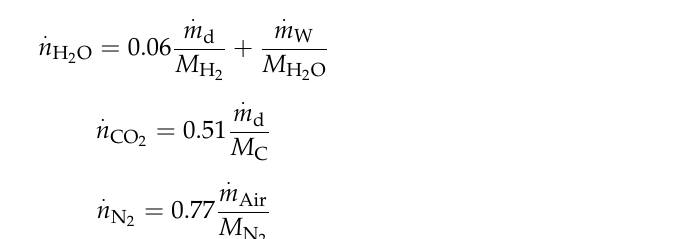
Figure 6. Measured and predicted outputs: moisture evaporation rate, fuel burning rate and flue gas content. The dynamics of the model states, including the temperature of char and gas, as well as the amount of char, fuel and water on the grate, are presented in Figure 7. The predicted gas and burning char (solid) temperatures are in a good agreement with the values previously measured by Cooper and Hallett [28]. The variations in fuel moisture content result in large changes in char and gas temperature, as presented in Figure 7, which have a major impact on the rates of combustion reactions. Moreover, switching to a dryer fuel raises the amount of char on the grate and simultaneously decreases the quantity of fuel and moisture. Thus, the increased char to fuel ratio requires the adjustment of primary to secondary air ratio in order to achieve clean combustion.